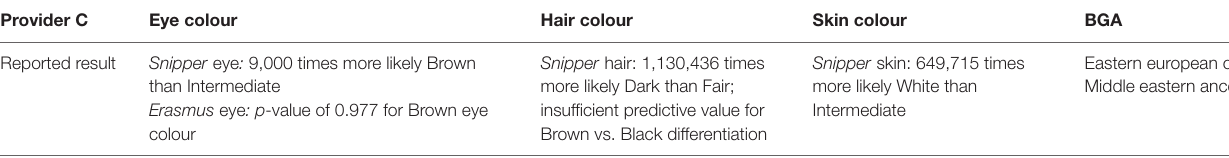
TABLE 6 | Provider C reporting style for eye colour, hair colour, skin colour, and BGA prediction.